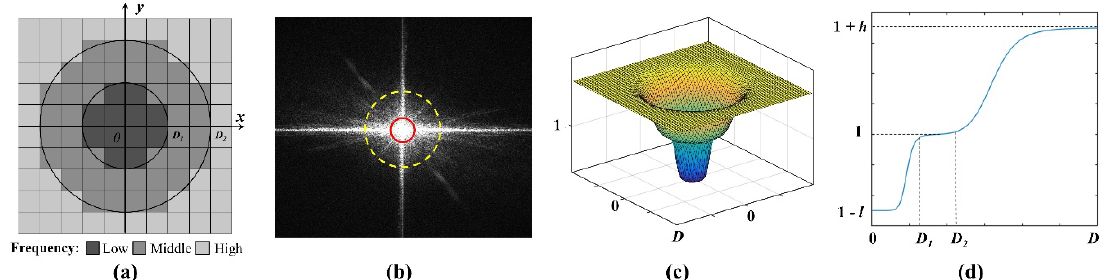
Figure 3. A graphical illustration of frequency domain equalizing: ( a ) the division of frequency domain; ( b ) an example of FT-based frequency power spectrum and frequency domain division (the low and high frequency region are displayed within the red and yellow circles, respectively); ( c ) multi-interval frequency domain equalization model visualized in3D; and ( d ) the multi-interval frequency domain equalization model and its performance in theory.